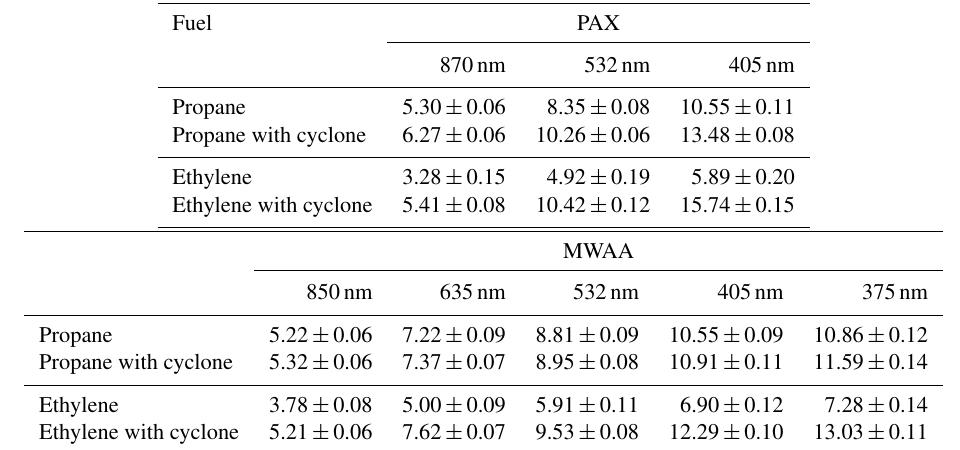
Table 3. Summary of the measured MAC values (m 2 g − 1